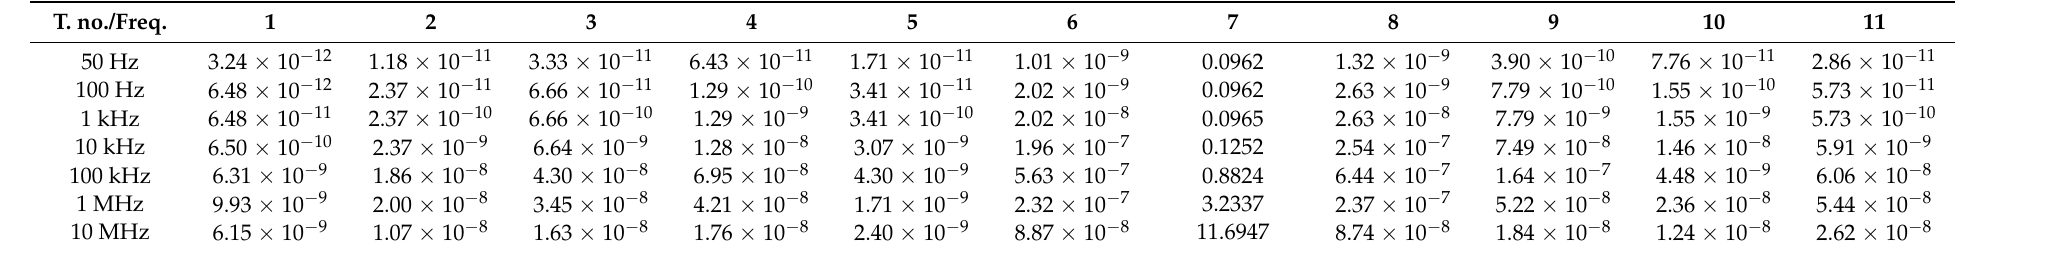
Table A16. Self and mutual resistances of turn 7 (in Ω ) resulting from FEM simulations. T. no./Freq.